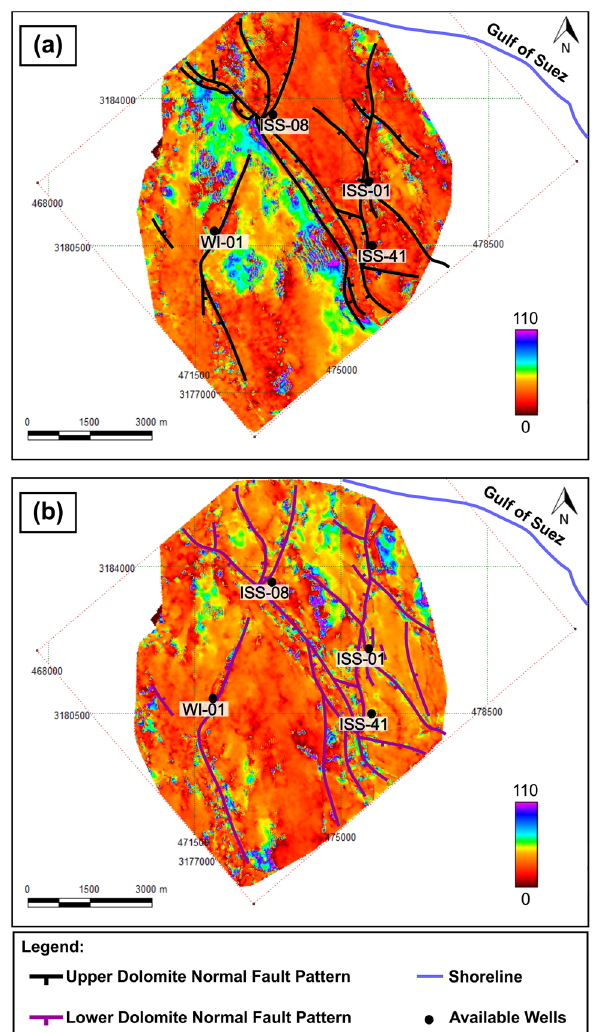
Fig. 15 Instantaneous Frequency surface attribute on the tops of a the Upper Dolomite and b the Lower Dolomite reservoirs. They show that the Upper Dolomite surface has a different instantaneous fre- quency response than the Lower Dolomite